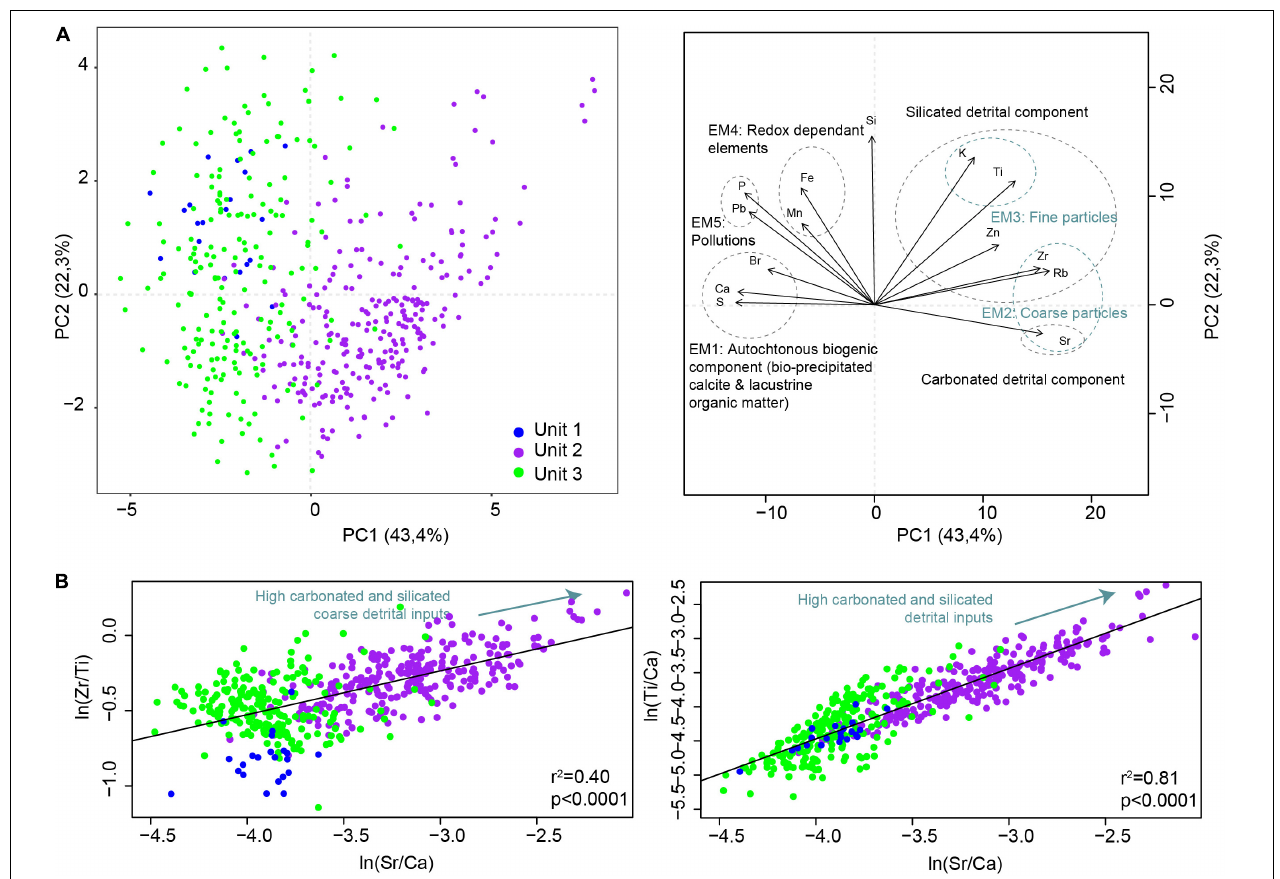
FIGURE 3 | Geochemical patterns from AIG16-MC. (A) Results from the PCA. Five end-members corresponding to sediment fractions of different origins or related to different sedimentary processes are highlighted. (B) Biplots comparing Zr/Ti (proxy of coarse and silicated detrital inputs) with Sr/Ca (proxy of the carbonated detrital fraction) on the left side and Ti/Ca (proxy of silicated detrital inputs) with Sr/Ca (proxy of carbonated detrital inputs) on the right